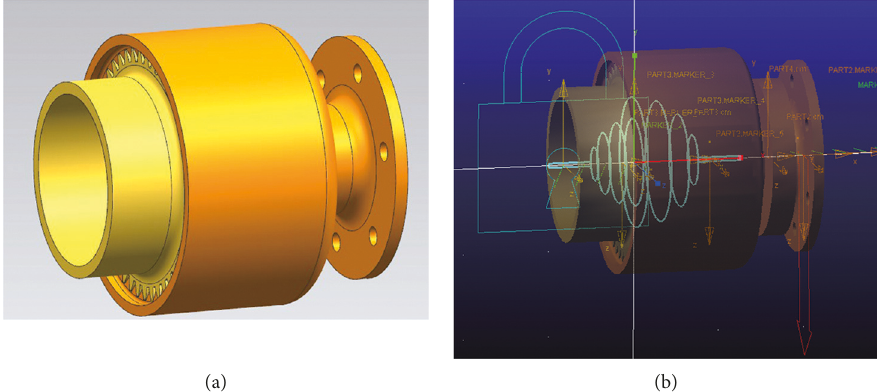
Figure 8: The solid model and kinematic simulation model of the crown gear coupling. (a) The solid model of the crown gear coupling. (b) The kinematic simulation model of the crown gear coupling.